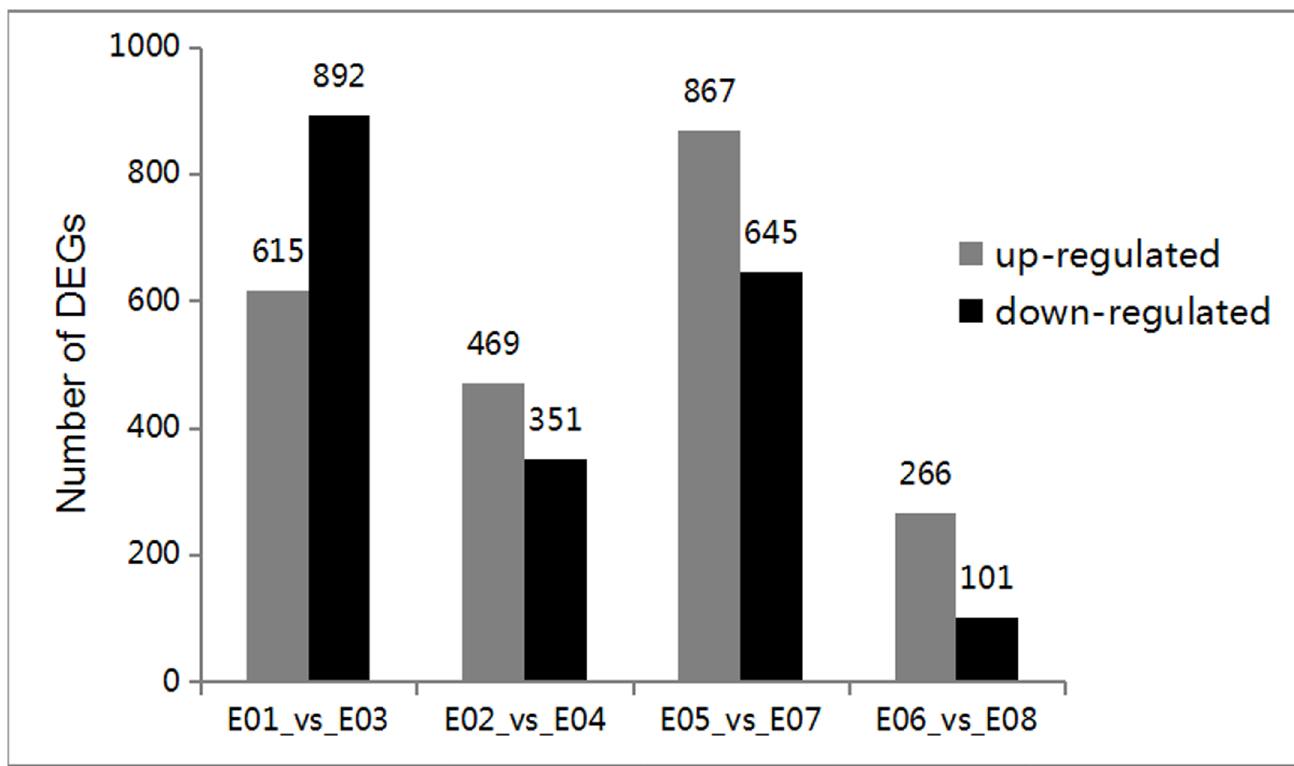
Fig 4. Number of differentially expressed genes in each comparison. The numbers of up-regulated (in red) and down-regulated genes (in blue) are presented.